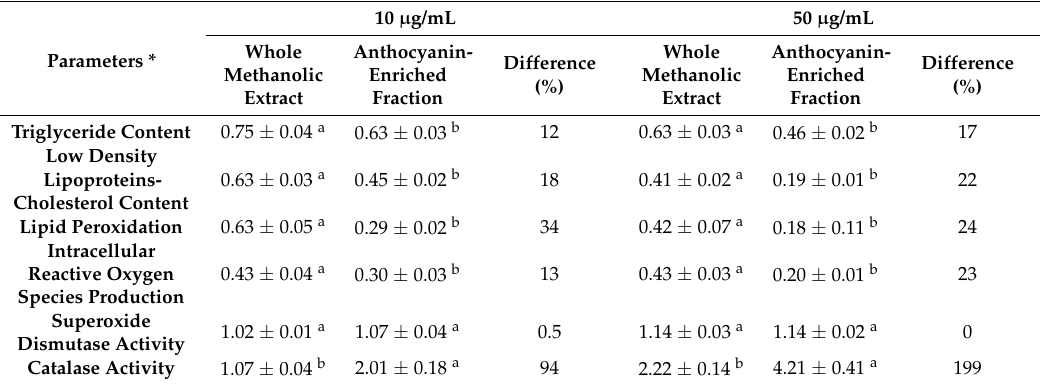
Table 3. Comparison between strawberry fractions when applied at the same